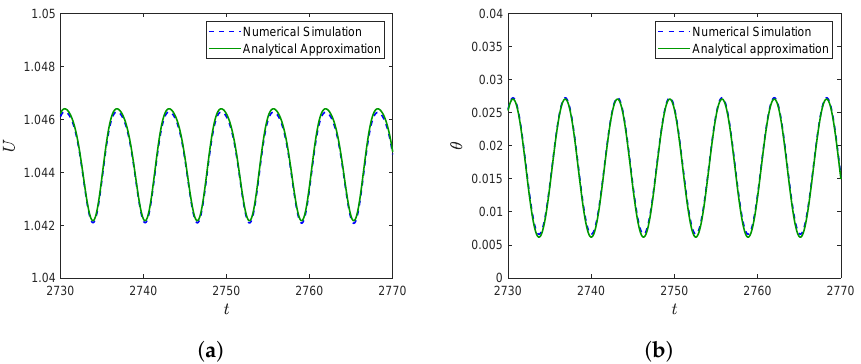
Figure 6. Comparison between theoretical and numerical final state at 5Hz. ( a ) Airspeed; ( b ) pitch